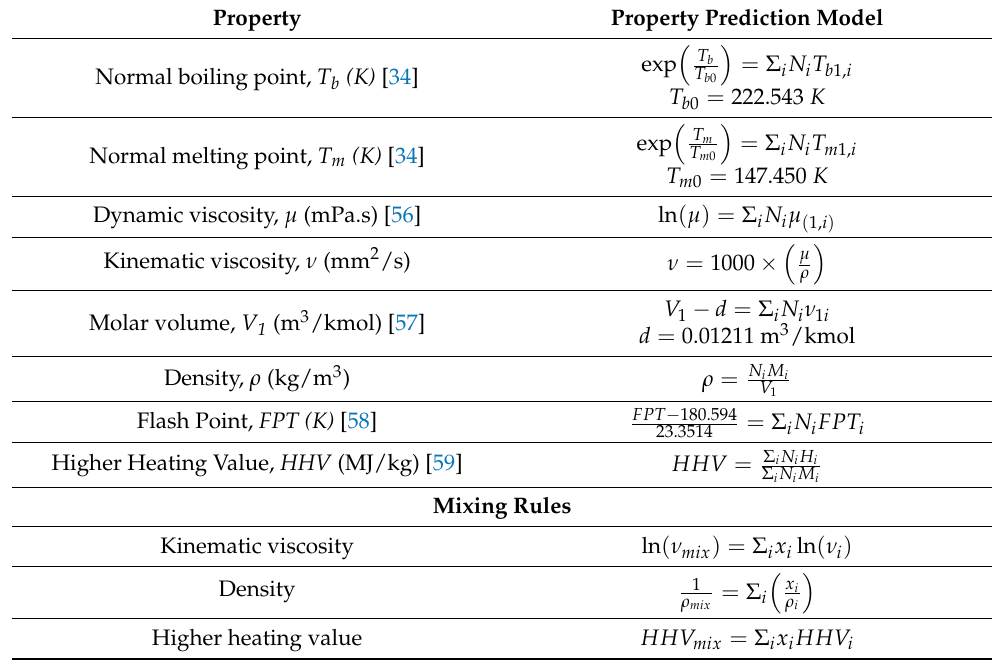
Table A1. Property prediction models and mixing rules.